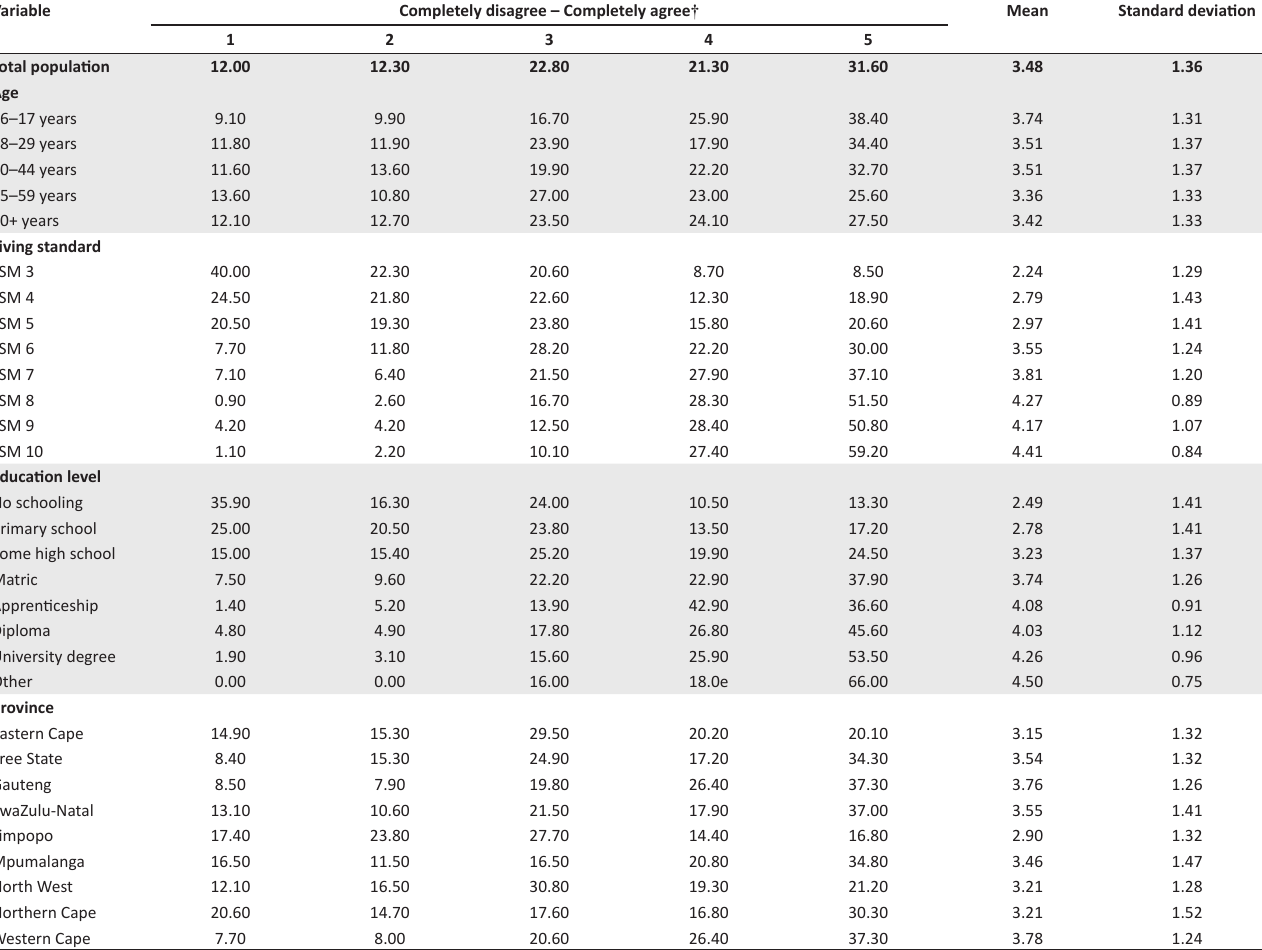
FIGURE 7: Distribution of happiness in South Africa based on the question whether respondents are happy with their lifestyles: 2015. TABLE 2: Distribution of reported happiness level (scales 1–5) by a range of geographic, demographic and socio-economic variables.